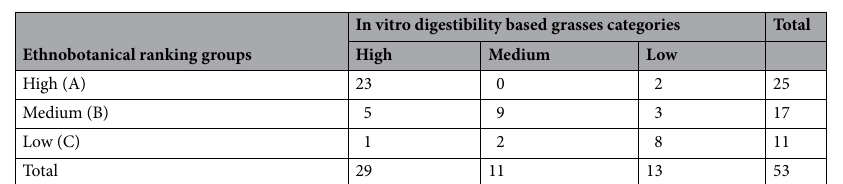
Table 4. Crosstab analyses between In vitro digestibility’s based grasses categories and ethnobotanical ranking groups of studied ethnobotanical fodder grasses.